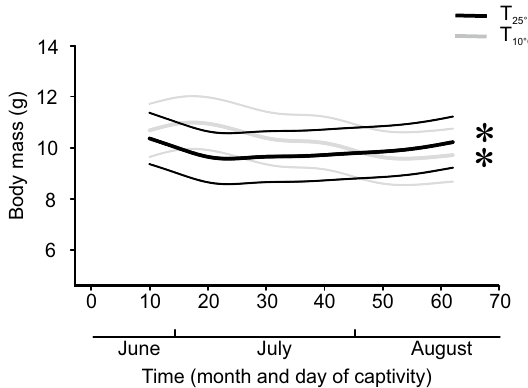
Figure 1. Modelled body mass of male bats in the two treatment groups. Data are shown in relation to time grouped by treatment. Thick lines represent the predicted body mass and thinner lines are 95% CI. Asterisks indicate significant